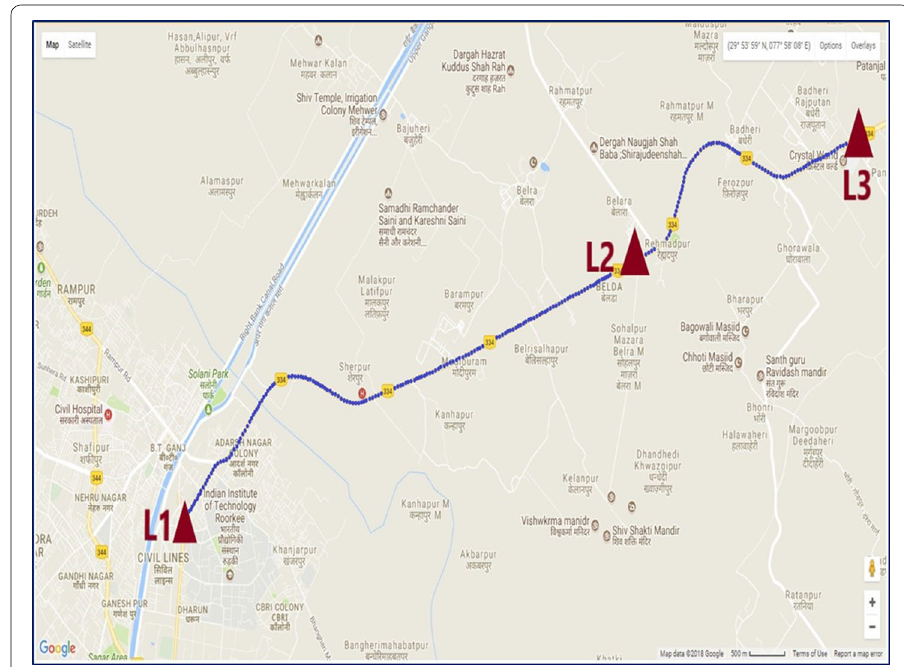
Fig. 1 The selected highway stretch on NH-58 (Roorkee to Hardwar